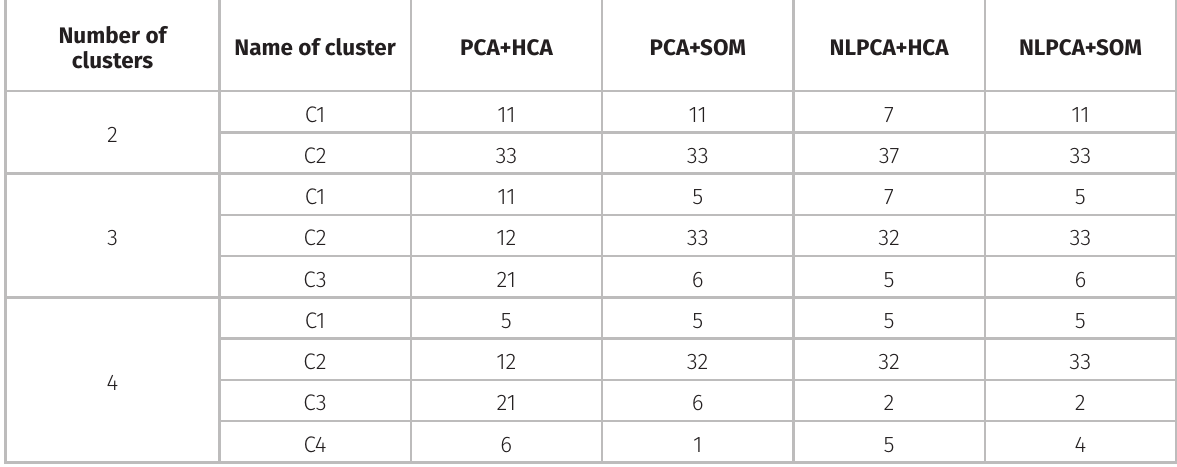
Table I. Results of regionalization by linear, non-linear and hybrid approaches Number of